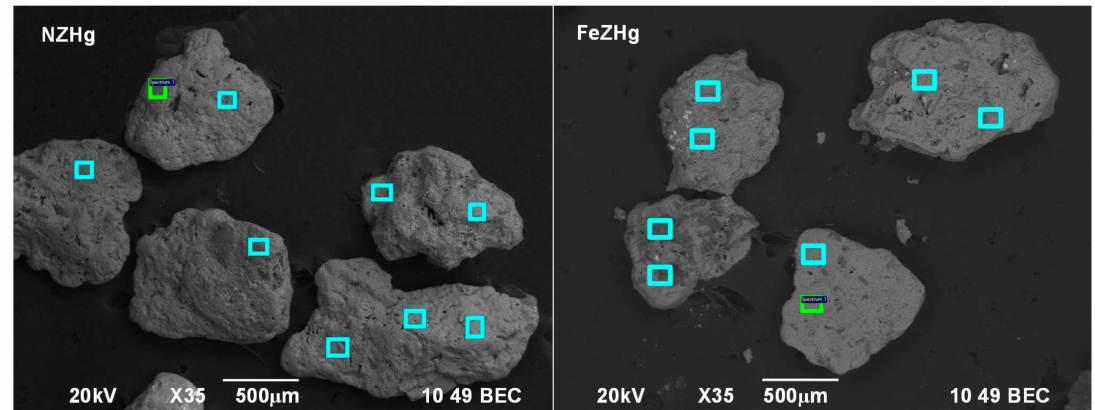
Figure 9. Backscattered electrons mode (BSE) images of NZHg and FeZHg with marked surfaces (Spectra, Sp) for energy dispersive X-ray (EDS) analysis.